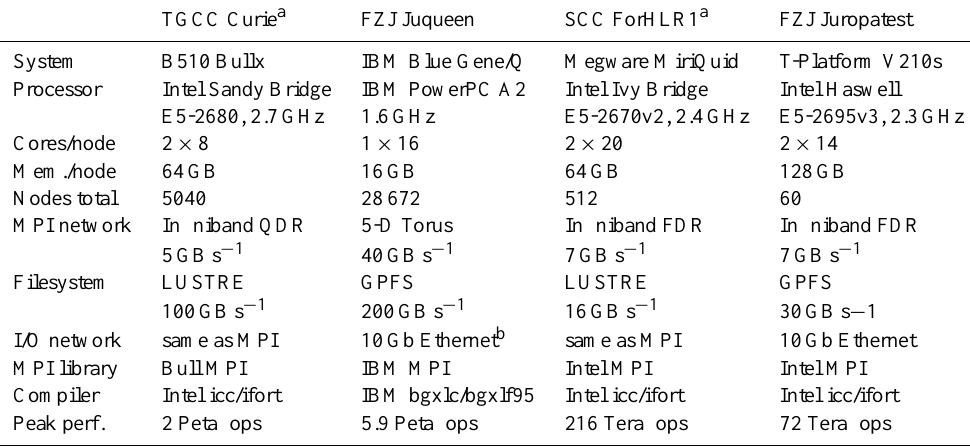
Table 1. Specifications of the four HPC facilities used for the medium-size scaling tests in Sect.